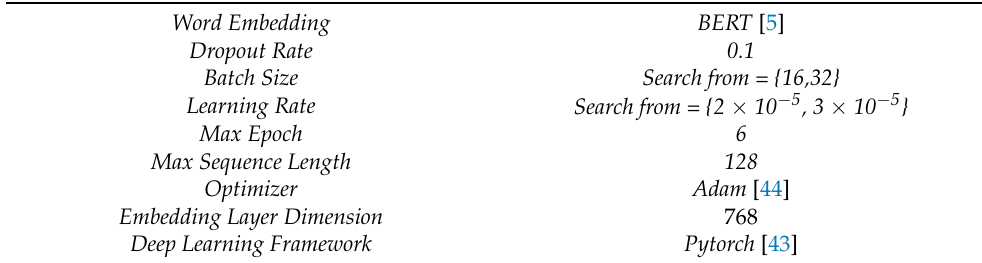
Table 4. Thedetailsofusedhyper-parametersandtheconfigurationsondeeplearning-basedBERTmethods.